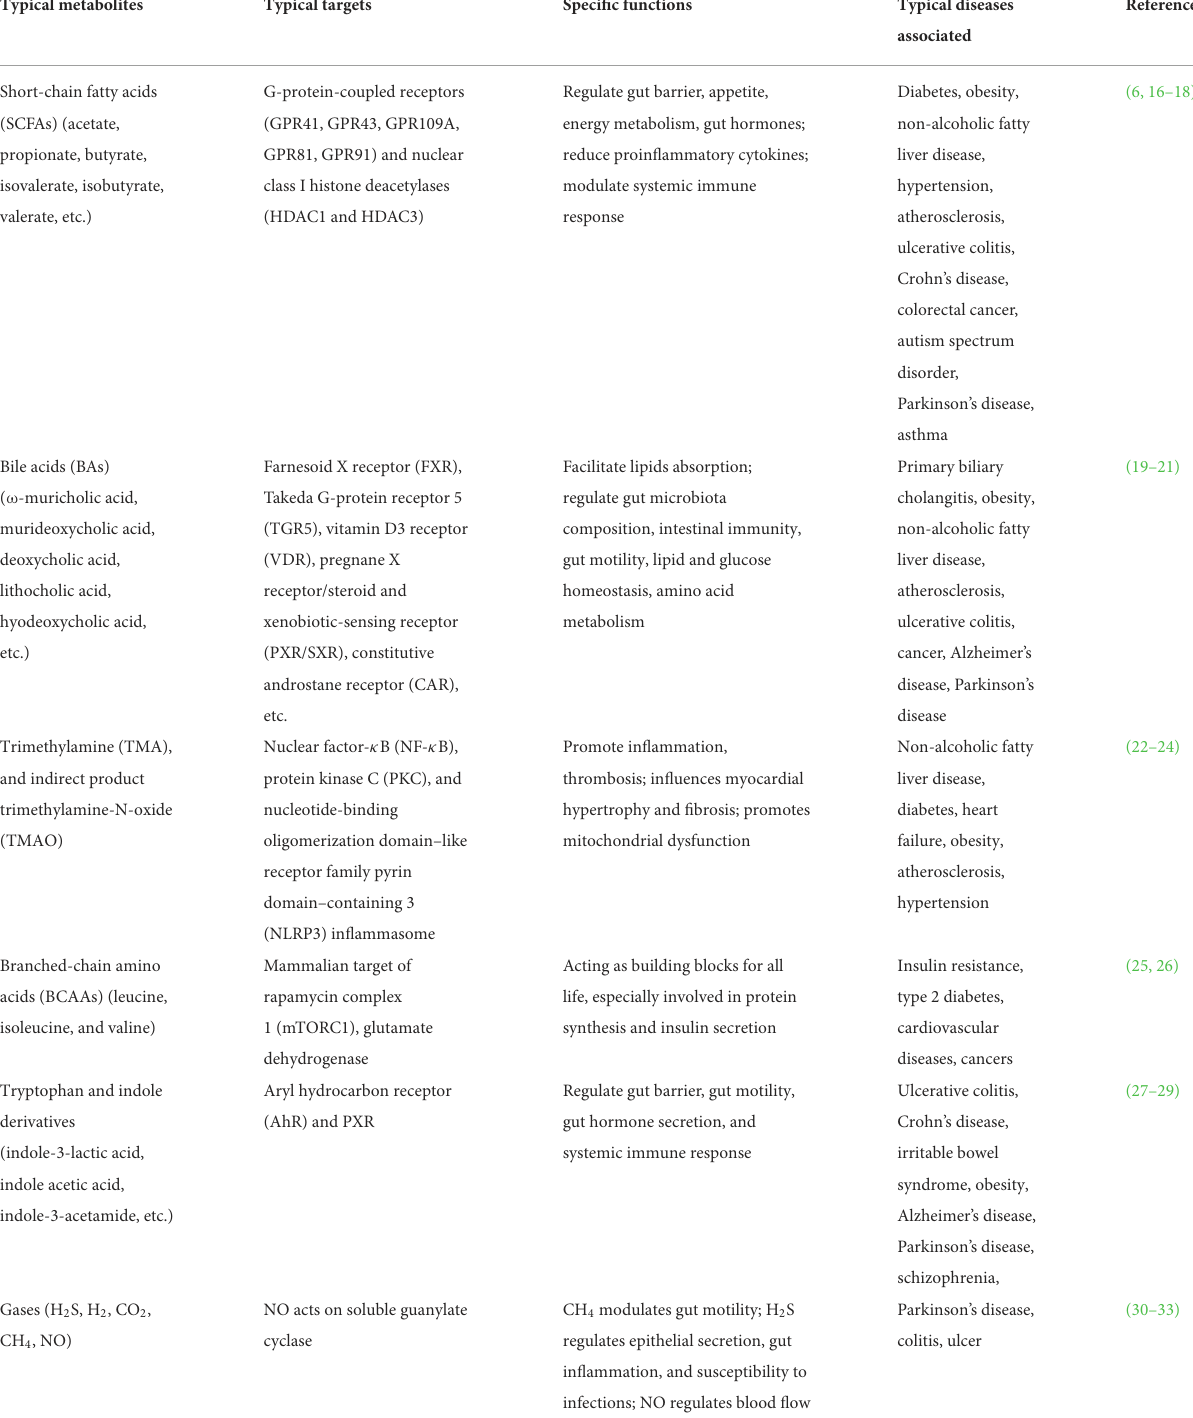
TABLE 1 Typical gut microbiota metabolites and their functions in health and